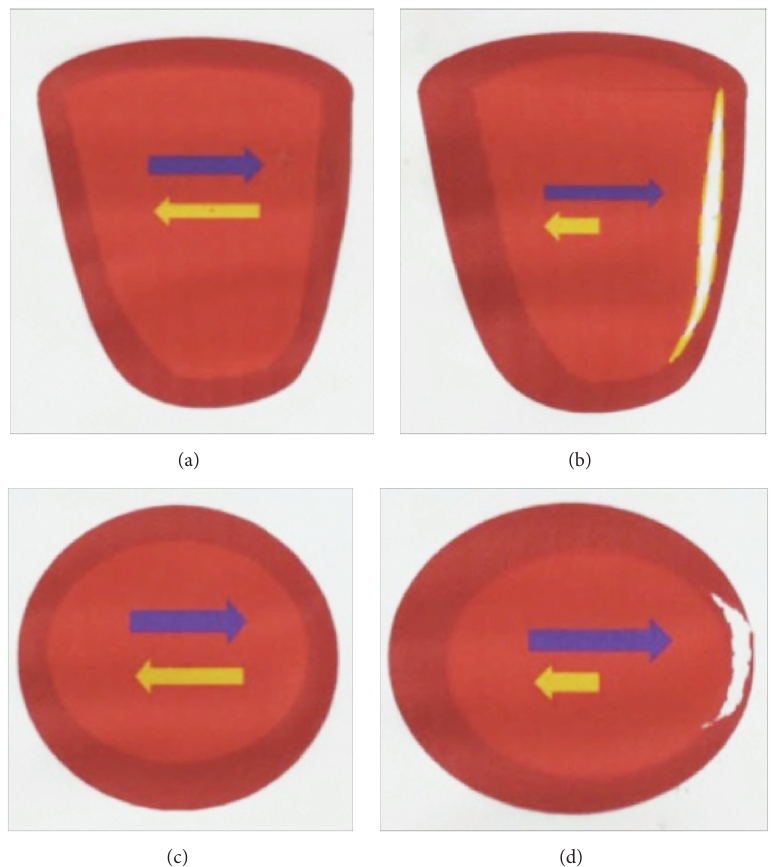
Figure 1: In a normal ventricle, the force generated by myocardial contraction is balanced (a and c). When there is an infarct scar (white), the infarcted segment is stretched by the force generated by the remote normal myocardium (b and d). As a result, the infarct scar expands and the infarcted wall becomes thinner, while the remote myocardium becomes hypertrophic to maintain a normal global cardiac function (d). Arrows indicate the vectors of forces generated by opposite left ventricular segments during